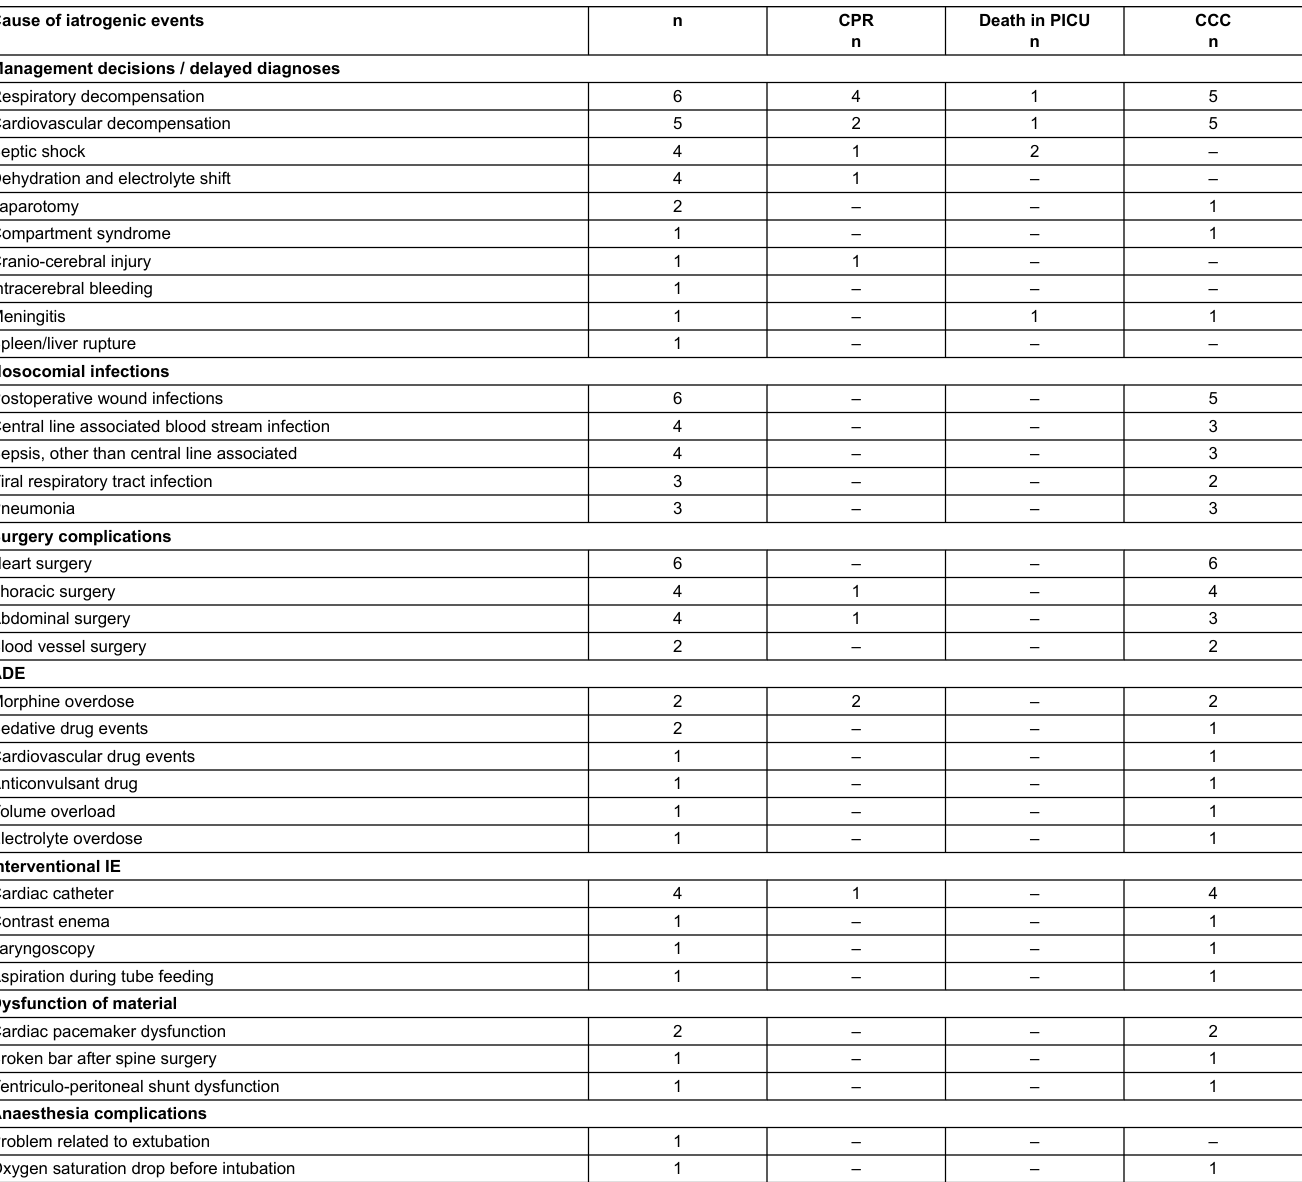
Table 4: Preventable iatrogenic events and